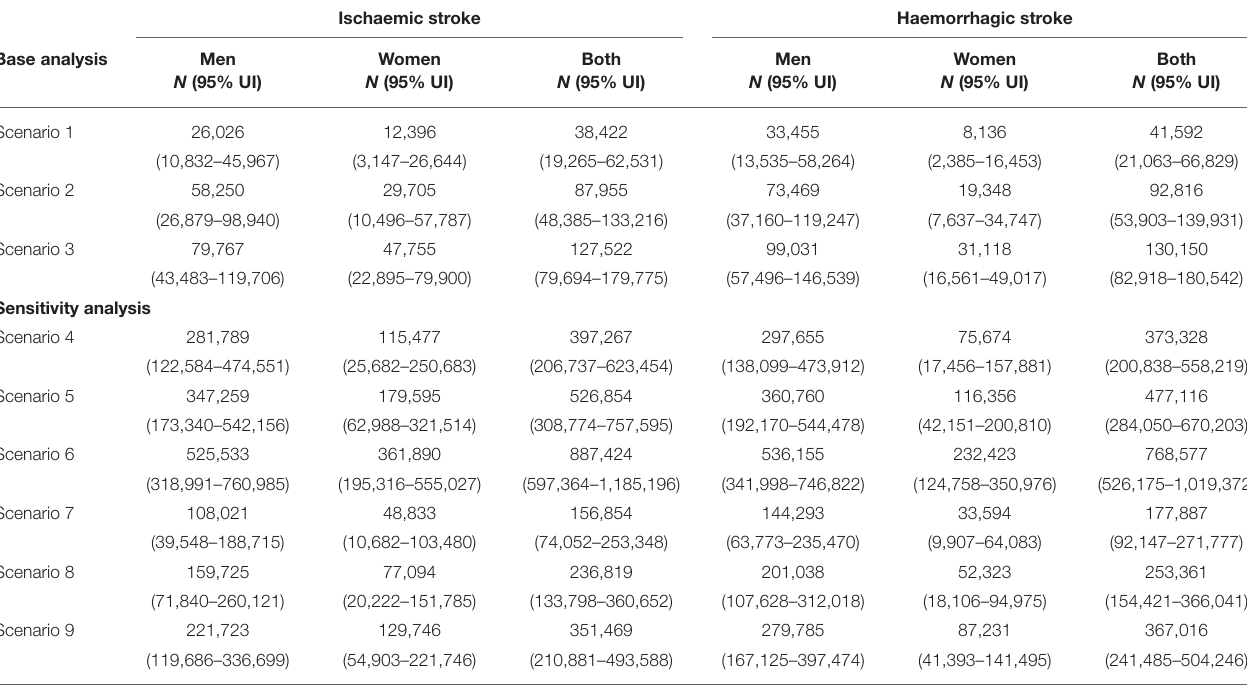
TABLE 2 | Absolute reductions in incident strokes among adults in Vietnam from 2019 to 2030 and over the